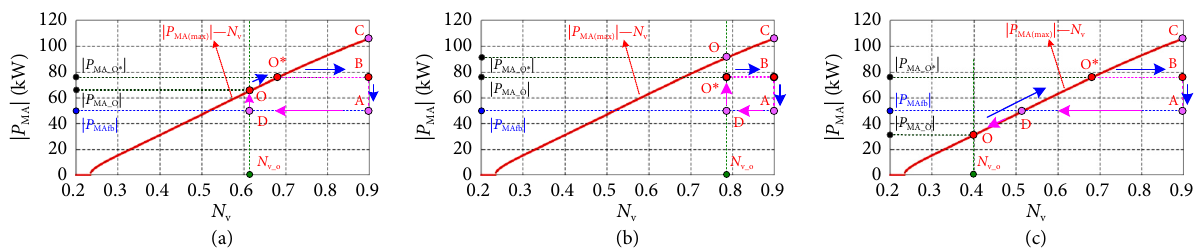
⩽ Fig. 7 Active-power regulation path during LVRT transition in the power-generation state. (a) | P MAfb | | P MA_O | | P MA_O *|. (b) | P MA_O | > | P MA_O *|. (c) | P MA_O | <